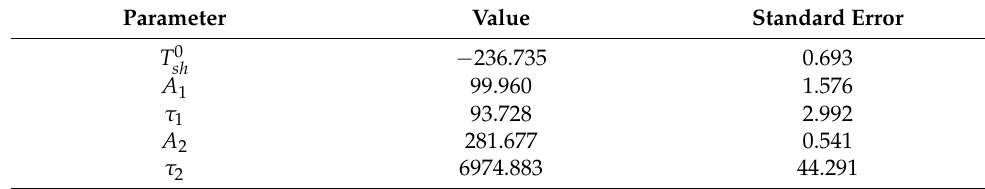
Table 7. Parameters determined for the fit of the dynamic simulation